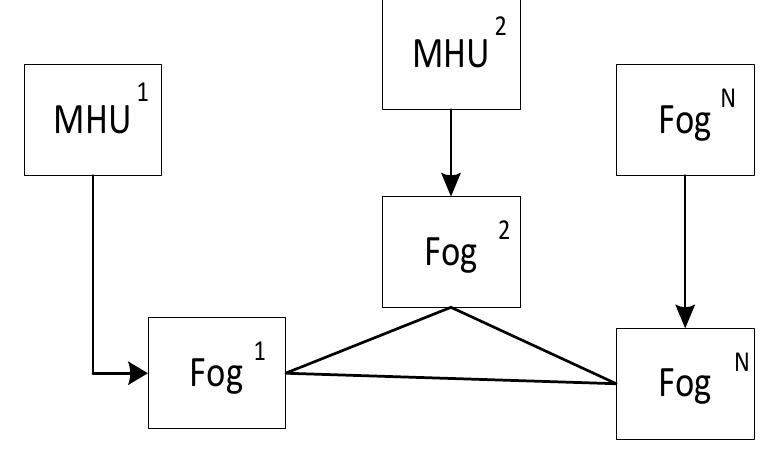
Figure 3. The overall flow of the proposed model.